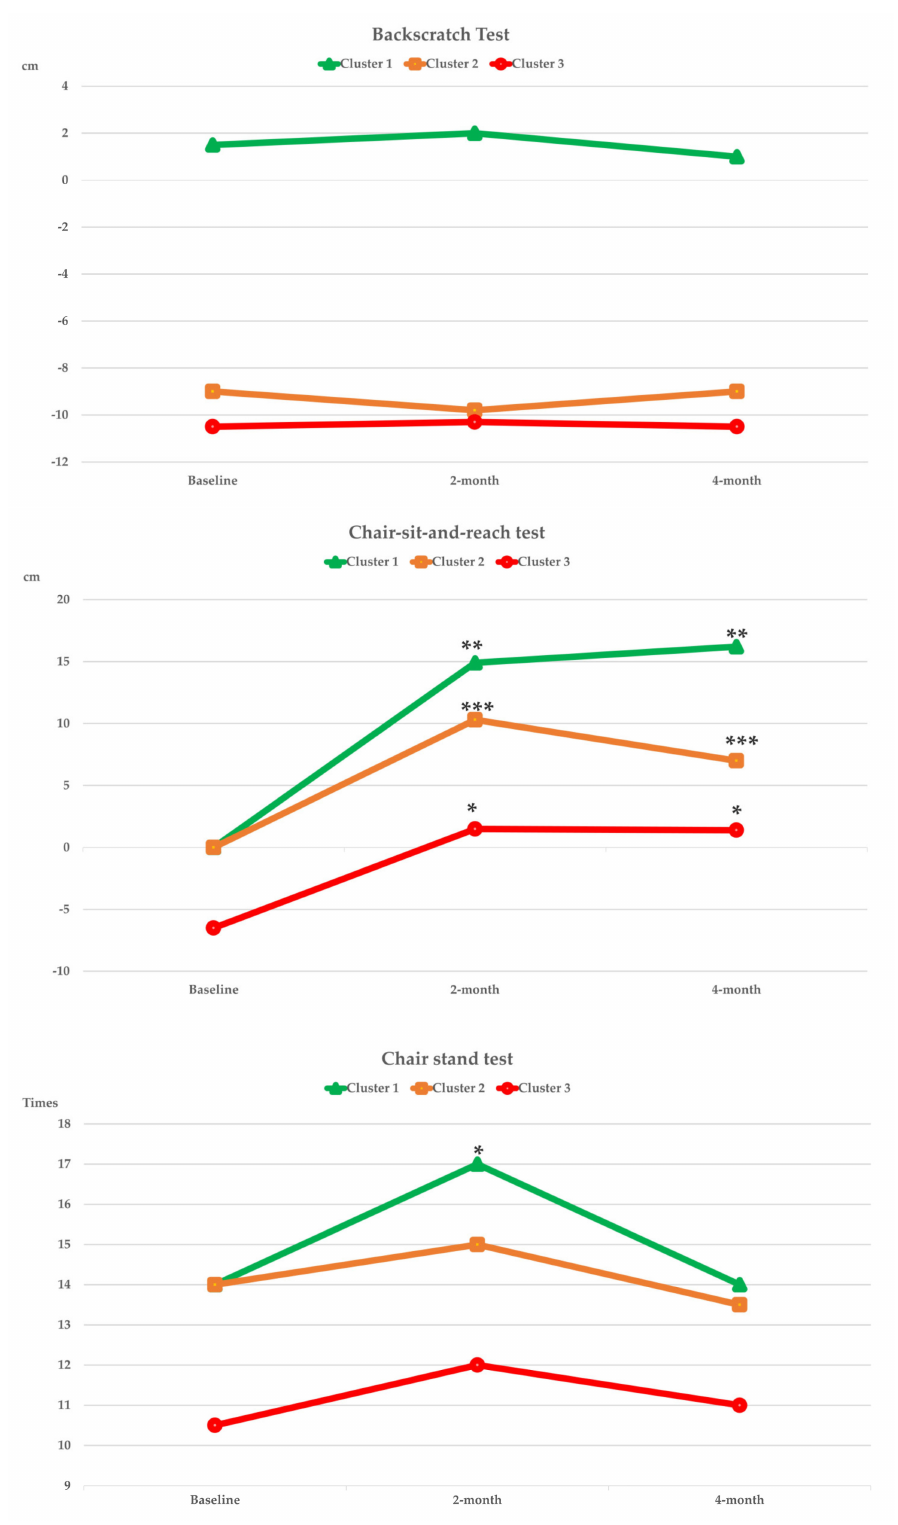
Figure 4. Curve chart for the within cluster comparison of median of intrinsic capacity in locomotion captured by BST, CSR, and CST at two-month and four-month of intervention. * , ** , *** Indicated significant different from baseline, compared by Wilcoxon Signed Rank test; * p < 0.05, ** p < 0.01, *** p < 0.001. BST, backscratch test; CSR, chair-sit-and-reach test; CST, Chair stand